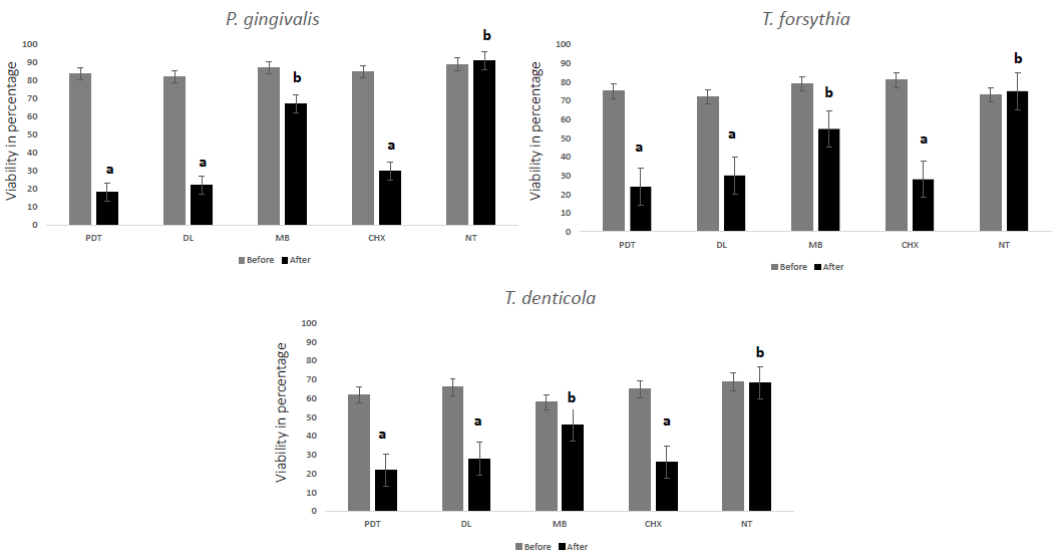
Figure 1. MTT assay showing relative percentage of P. gingivalis , T. forsythia and T. denticola biofilm viability with different treatment groups. Dissimilar letters indicate statistical significance between groups using ANOVA test followed by Tukey’s test.